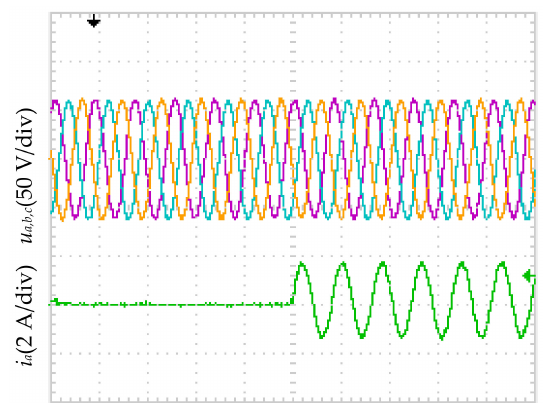
Figure 17. Three-phase output voltages and c-phase current of switching from unbalanced load to balanced load.